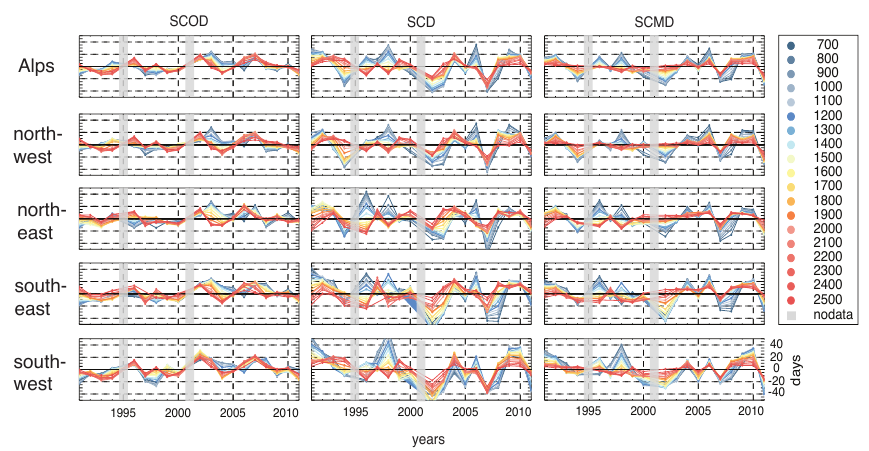
Fig. 9. Annual departures (1991–2011) of SCOD, SCD and SCMD from the long-term median for the Alpine region and all subregions given in days for different altitude levels. Years refer to 1 January. Connecting lines are displayed for easier readability of the figure only. The data coverage in 1995 and 2001 was insufficient for the application.